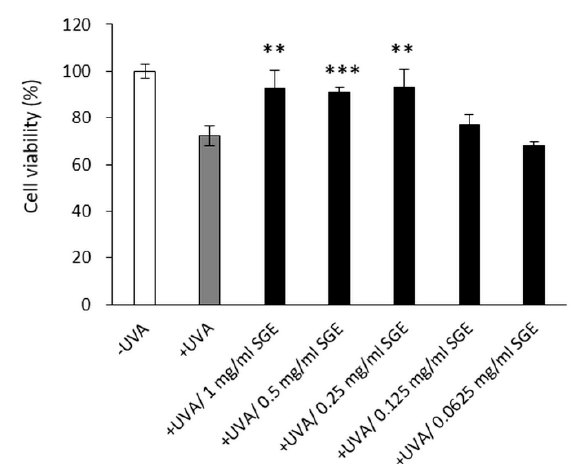
Figure 3. SGE recovered CCD-966SK cell regeneration after UVA irradiation. Cells were pretreated with UVA for 1 hour (+UVA, grey bar), and then treated with 0.0625, 0.125, 0.25, 0.5 or 1 mg/ml of SGE (black bars), or left untreated as negative control ( − UVA, white bar, 100%). SGE was able to recover dermal fibroblasts from UVA irradiation by the treatment concentrations of 0.25, 0.5 and 1 mg/ml. **, P < 0.01 versus +UVA; ***, P < 0.001 versus +UVA. SGE, Sargassum glaucescens extracts.